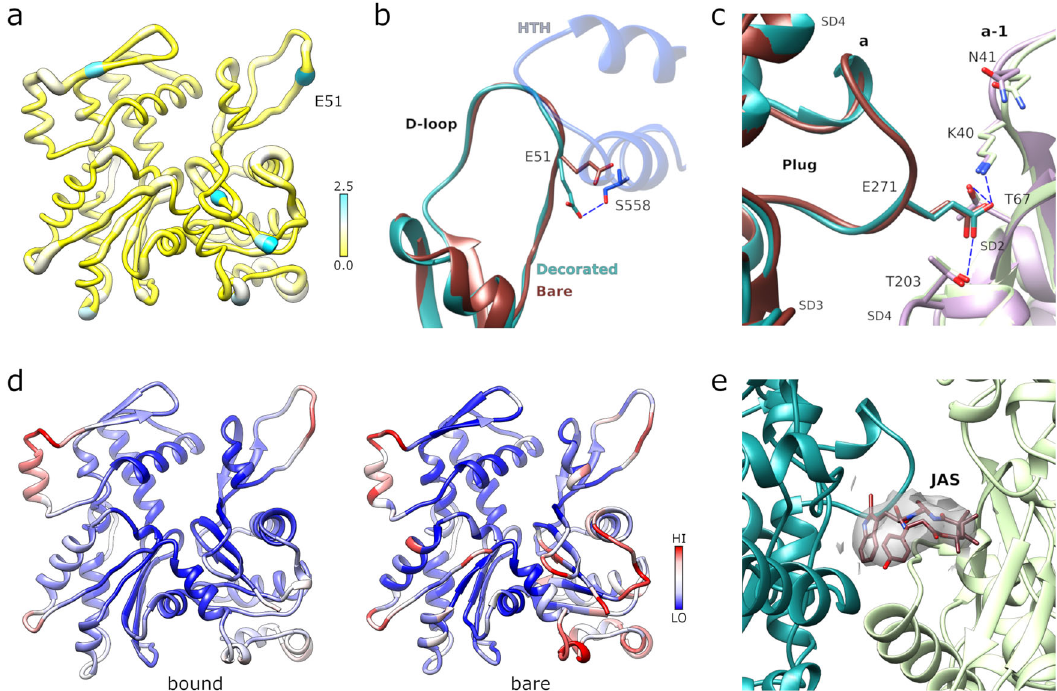
Fig. 3 Structure of the PfMyoA-bound PfAct1 fi lament. a Atomic model of fi lamentous PfAct1 while bound to PfMyoA with root mean square differences to the bare PfAct1 fi lament structure mapped in thickness and color, from 0 – 2.5 Å. b The D-loop shows only minor structural differences in the bound (cyan) compared to the bare (chocolate red) fi lament (PDB code 5OGW; https://www.rcsb.org/structure/5OGW) 11 with the largest difference occurring at residue E51. In the decorated fi lament, the conformation of the sidechain of E51 is reoriented in order to establish a polar contact of with S558 from the HTH of PfMyoA (dark blue). c The plug conformation is identical in both structures and the speci fi c polar interactions are conserved. d Comparison of the normalized atomic temperature factors between the bound (left) and unbound (right) PfAct1structures. e Jasplakinolide (JAS) is well de fi ned in the density map of the PfMyoA bound PfAct1